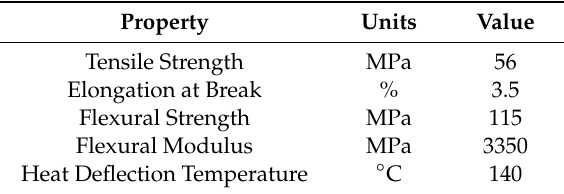
Table 4. Main properties of the resin selected to print the micro molding tooling inserts [28].